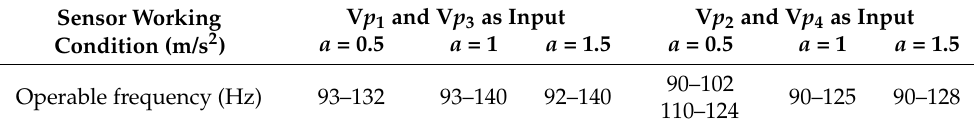
Table 6 records the output state of the SDO pin of the MS5607 pressure sensor under the vibration frequency range of 90–140 Hz and the acceleration of 0.5–1.5 m/s 2 ( a = 0.5–1.5 m/s 2 ) , respectively. V p 1 and V p 3 were used as inputs to drive the sensor harvested simultaneously by the MSI-SECE circuit with a greater effect. With the increase in acceleration, the effective working frequency band was gradually widened. When the frequency was 90–93 Hz, V p 1 and V p 3 as the input power did not drive the sensor to operate, but V p 2 and V p 4 met the energy demand. When the frequency was 125–140 Hz, V p 2 and V p 4 as the input power did not drive the sensor, but V p 1 and V p 3 met the energy demand. Obviously, the results show that the four charge sources are divided into two groups that produce complementary frequency ranges and ensure that the pressure sensor can output the signal normally in the frequency range of 90–140 Hz. Table 6. Operating status of the air pressure sensor at a 90–140 Hz vibration frequency. Sensor Working Condition (m/s 2